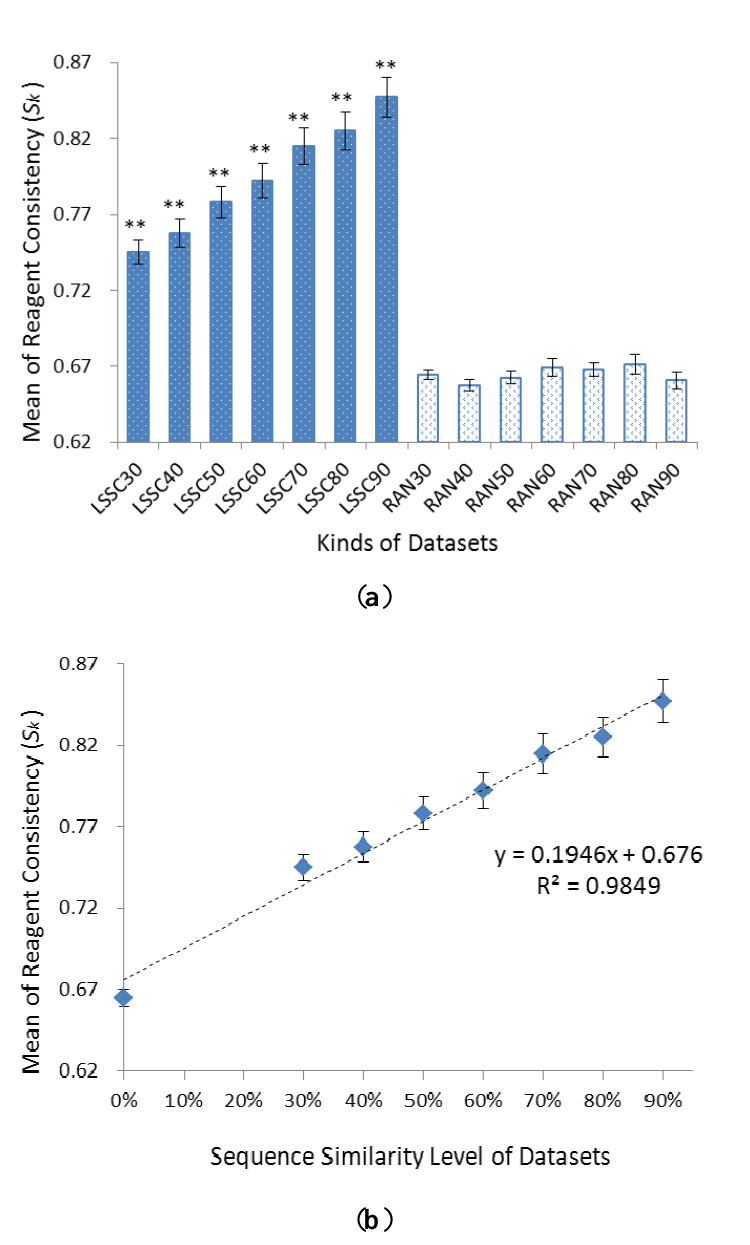
Figure 2. ( a ) The reagent consistency within each LSSC ( (cid:1845) ( (cid:1845) ). (Error Bar: standard error of mean; ** p < 0.001 of the t -test results). ( b ) The (cid:3019)(cid:3002)(cid:3015) reagent consistency against the sequence similarity level of the LSSC and random datasets. (Error bar: standard error of mean; Dashed line: the linear regression line between reagent consistency and sequence similarity.)